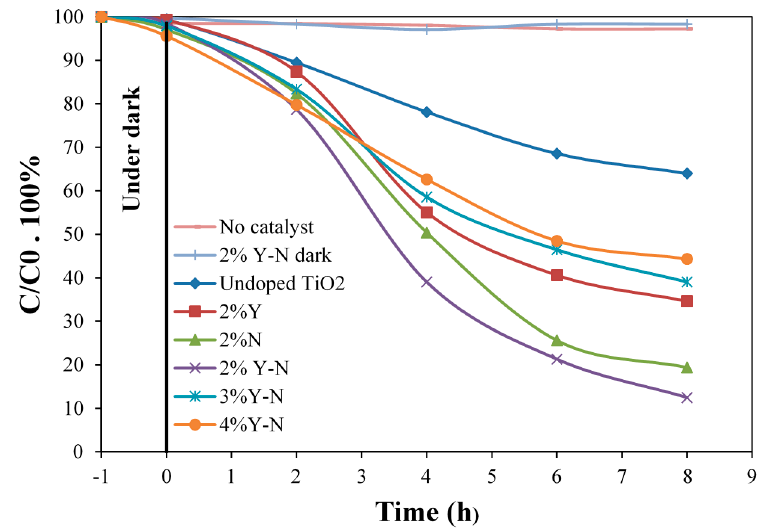
Figure 7. Evolution of the residual concentration of toluidine in the presence of undoped, Y-N doped and codoped TiO 2 thin films annealed at 400 °C.